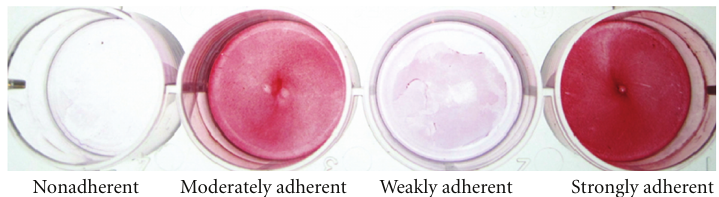
Figure 1: Total biofilm formation of di ff erent clinical MRSA isolates. The bacteria were grown in 6-well tissue culture plates containing TSB supplemented with 1% glucose. The cells that adhered to the plate surface after washing were visualised by staining with safranin. The clones were considered as highly, strongly, moderately, weakly, and nonadherent based upon their absorbance as measured by a spectrophotometer.